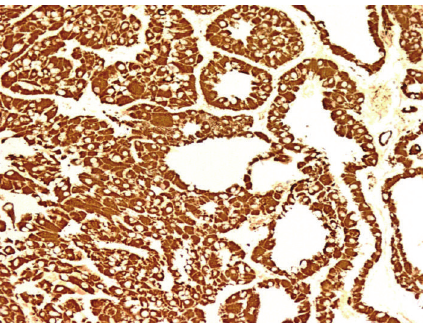
Figure 4: Tumor cells showing diffuse granular cytoplasmic posi- tivity for Hep-par 1 in HCC, immunohistochemistry